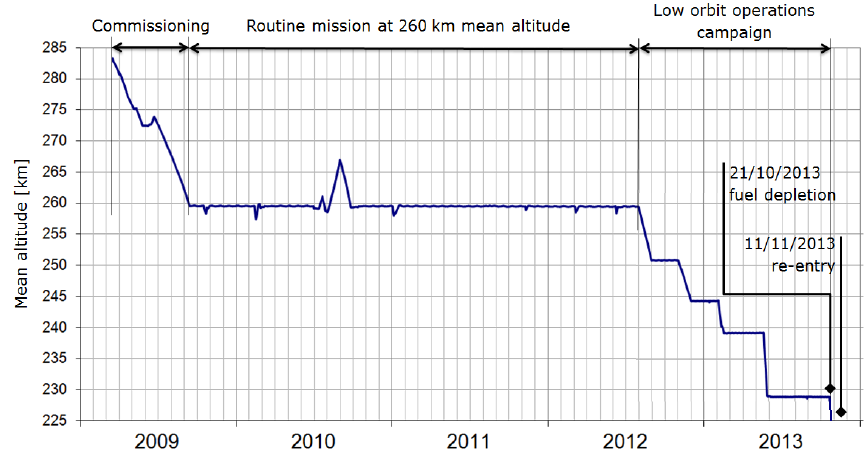
Figure 1. GOCE mission profile (GOCE Flight Control Team, HSO-OEG, 2014). Low-orbit campaign (260–230km height) starts on 1 Au- gust 2012 and goes through until the end of the mission on 20 October 2013.